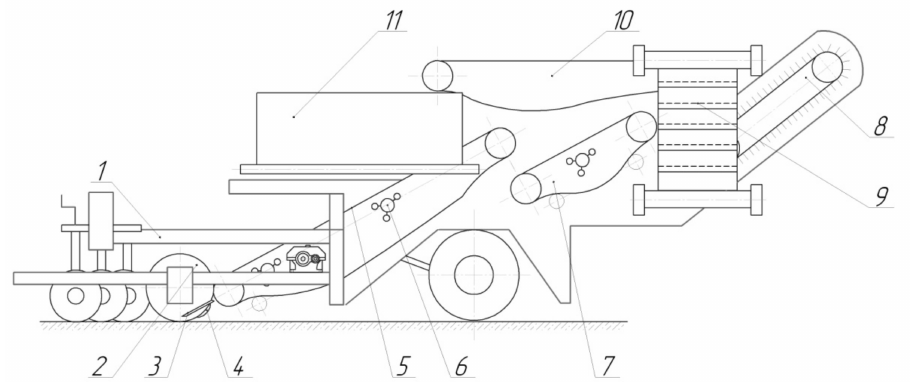
Figure 13. Technological scheme of the AVR-Spirit-6200 combine: 1—frame; 2—vertical disks; 3—digging share; 4—support wheel; 5—main elevator; 6—shaker; 7—cascade elevator; 8—finger slide; 9—bucket elevator; 10—bulkhead table; 11—bunker.